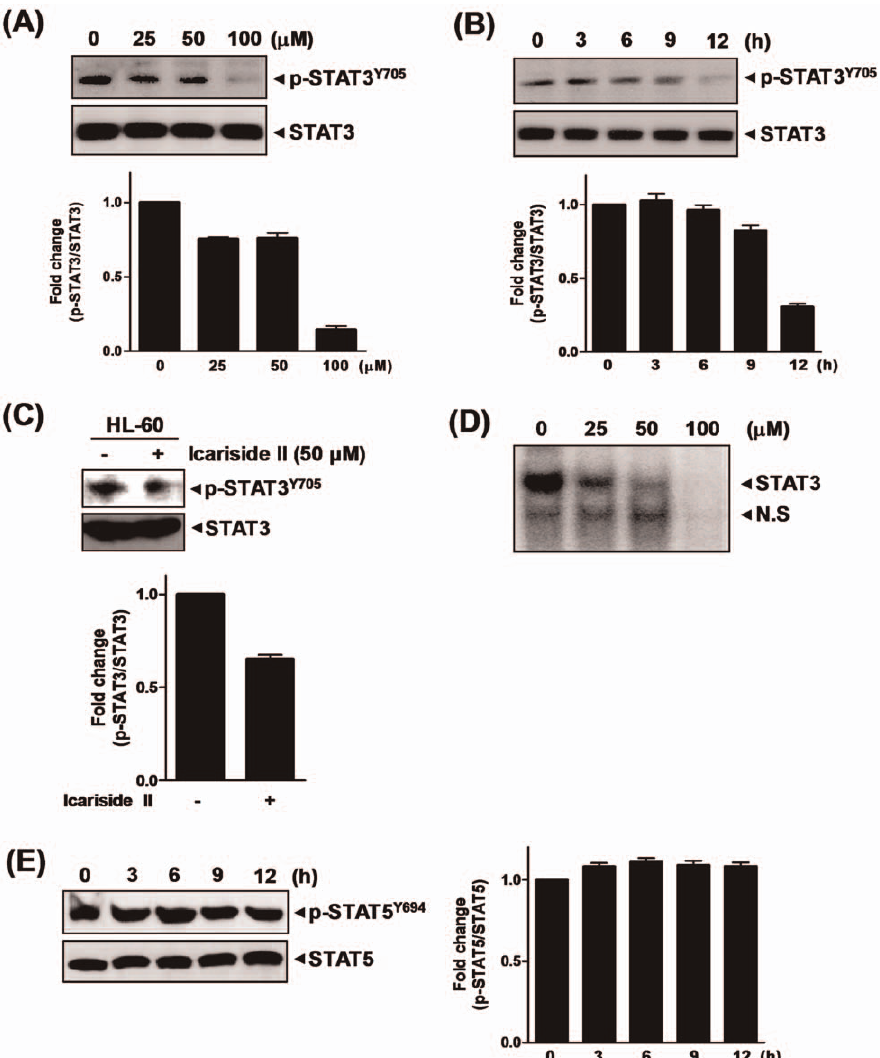
Figure 4. Inhibitory effect of Icariside II on activation of STAT3 in U937 cells. (A) U937 cells were treated with Icariside II (0, 25, 50 or 100 m M) for 9 h. (B) U937 cells were treated with Icariside II (50 m M) for 0, 3, 6, 9 or 12 h. Cell lysates were prepared and subjected to Western blotting for phospho-STAT3 and STAT3. (C) HL-60 cells were treated with or without Icariside II (50 m M) for 9 h. Western blotting was performed for phospho- STAT3 and STAT3. (D) U937 cells were treated with Icariside II (0, 25, 50 or 100 m M) for 9 h. EMSA was performed to determine the STAT3/DNA binding activity. N.S.; nonspecific binding. (E) U937 cells were treated with Icariside II (50 m M) for 0, 3, 6, 9 or 12 h. Western blotting was performed for phospho-STAT5 and STAT5. Representative results of three independent experiments are shown for each